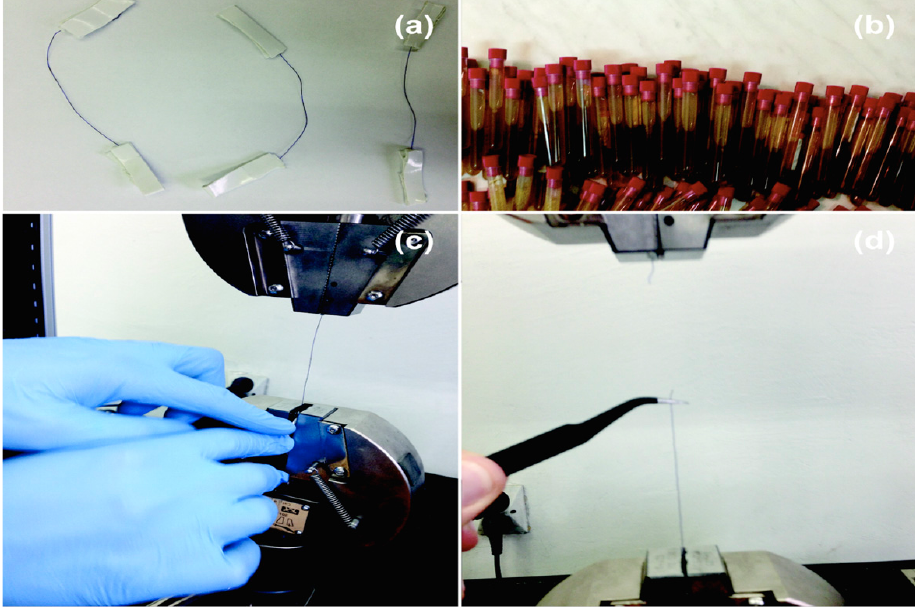
Figure 1. Stages of the experiment: (a) sutures before the stretch testing ; (b) collected sterile bile and sterile pancreatic juice in cryotubes; (c) INSTRON tensile machine; (d) suture after stretch test.